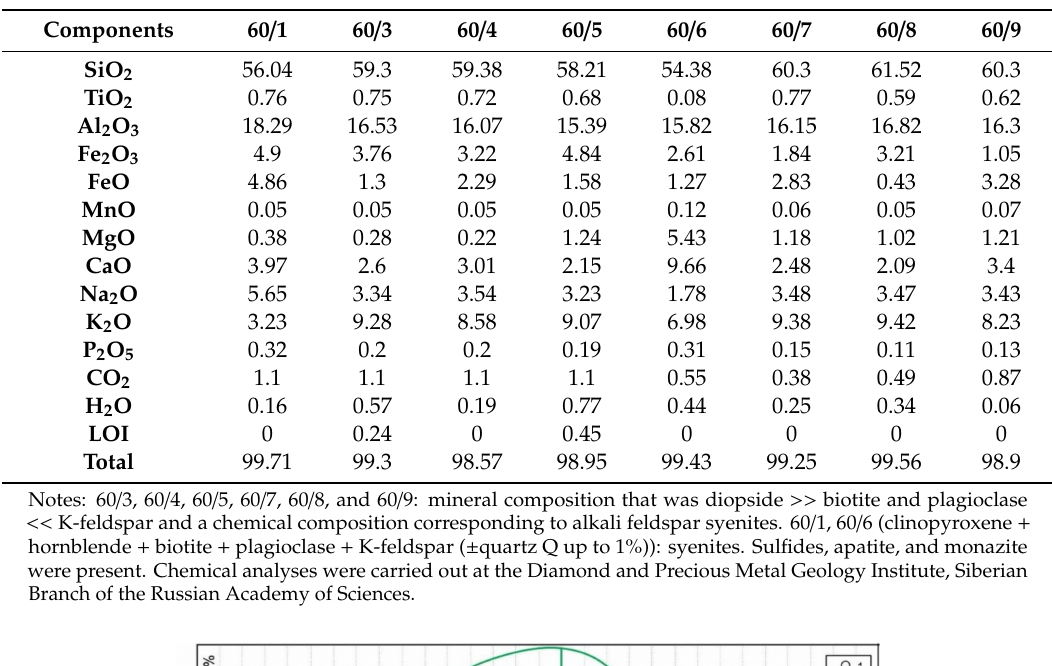
Table 1. Chemical compositions of the sulfidized rocks (in wt.%).